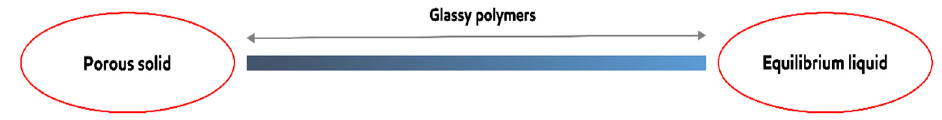
Figure 1. Continuum behavior of a glassy polymer membrane.